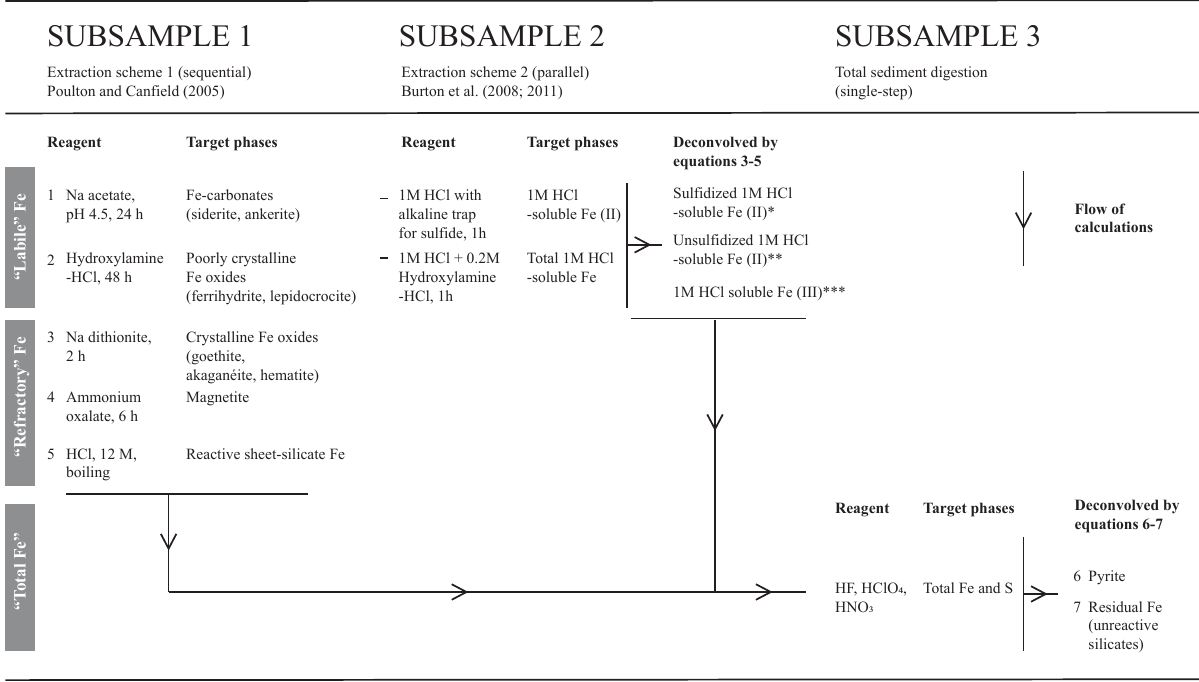
Table 2. Protocol for sediment Fe extractions employed in this study. The results of the extractions are combined according to Eqs. 3–7 (see